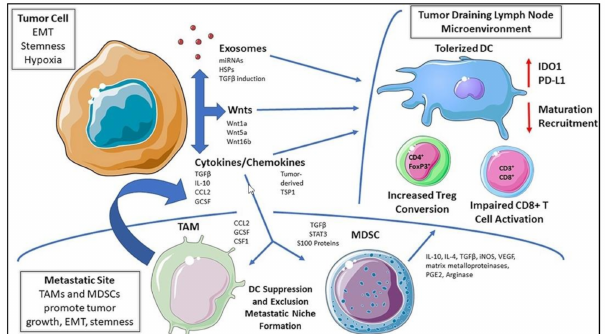
Figure 5. Mechanisms of DC tolerance in the tumor microenvironment. It is possible for tumor- derived soluble mediators to functionally tolerate DCs located inside tumor beds, tumor-draining lymph node tissues, or at more distant metastatic sites. This pathway promotes DC-dependent Treg differentiation while suppressing DC-mediated effector T cell responses, which aids in tumor development and progression. Reproduced with permission from [69]. Copyright 2019, Frontiers Media